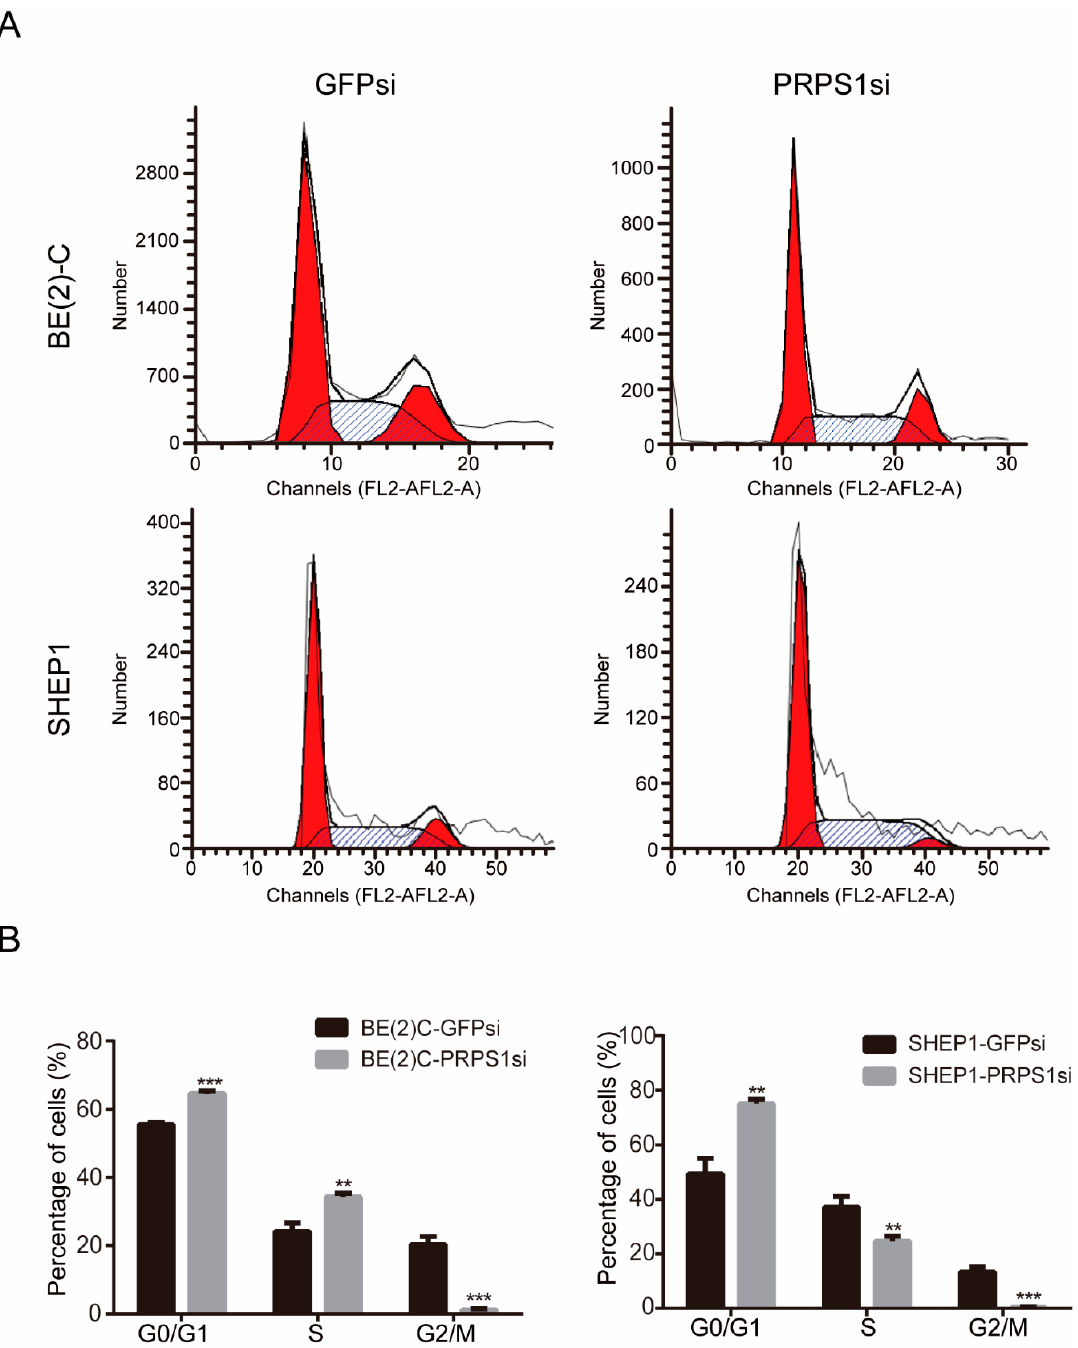
Figure 4. Down-regulation of PRPS1 arrests the cell cycle of neuroblastoma cells. ( A ) Flow cytometry analysis of the cell cycle distributions. ( B ) Statistical analysis of the cell cycle phase distribution. Values in panels B represent the averages obtained from three independent experiments, and the error bars show S.D. Statistical analyses were performed using two-tailed Student’s t -tests, *** p < 0.001, ** p < 0.01.